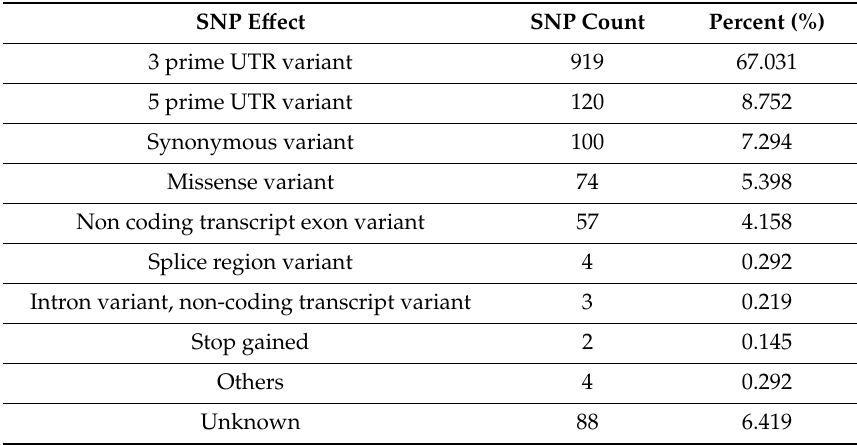
Table 3. Putative SNPs detected in boar